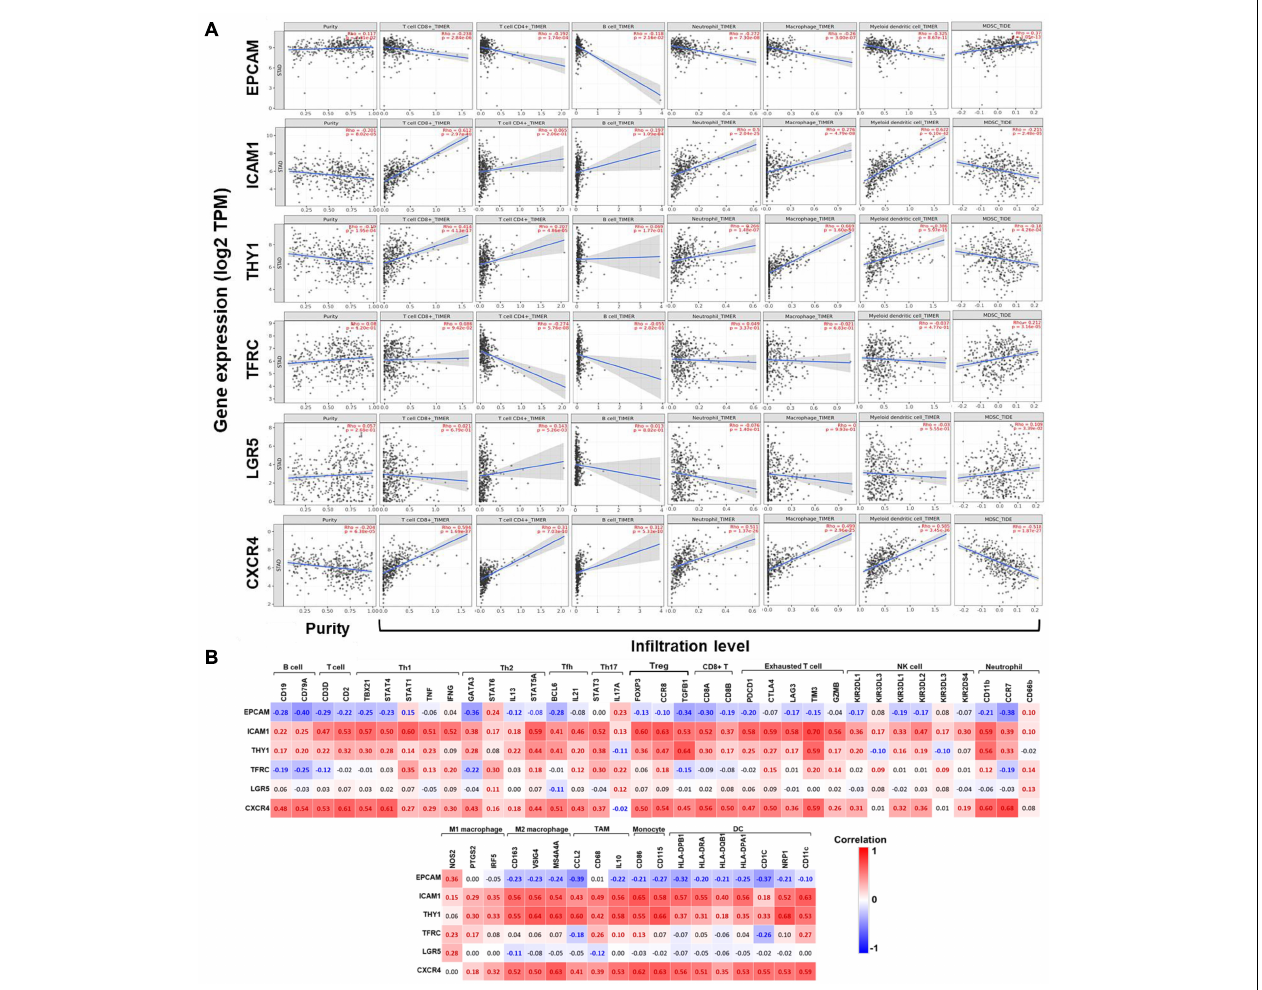
FIGURE 5 | Correlations between the expression of GCSC markers with immune infiltration in GC. (A) Correlations between expression of GCSC markers with tumor purity, and infiltration level of CD8+ T cells, CD4+ T cells, B cells, neutrophils, macrophages, DCs, and MDSCs in GC (TIMER). (B) Heatmaps show correlations between the expression of GCSC markers with biomarkers of TIICs in GC. Correlation coefficients with statistical significance are in bold, red or blue color represents positive or negative correlation, respectively. TAM, tumor-associated macrophage; Th, helper T cell; Tfh, follicular helper T cell; Treg, regulatory T cell; NK, natural killer cell; DC, dendritic cell; MDSC, myeloid-derived suppressor